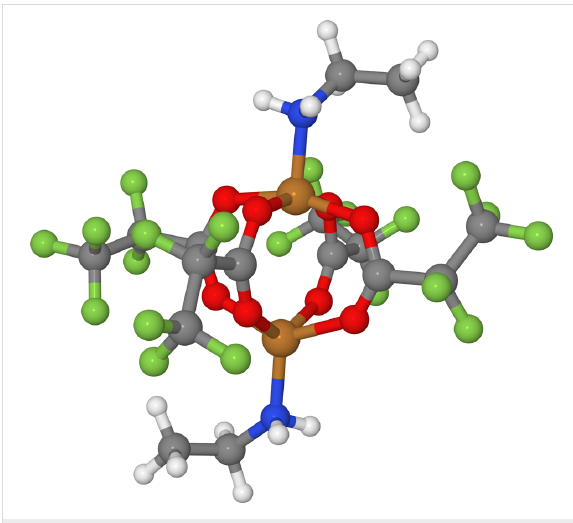
Figure 1: Schematic view of compound B, [Cu 2 (EtNH 2 ) 2 ( μ - O 2 CC 2 F 5 ) 4 ]; (H in white, C in grey, N in blue, O in red, F in green, Cu in